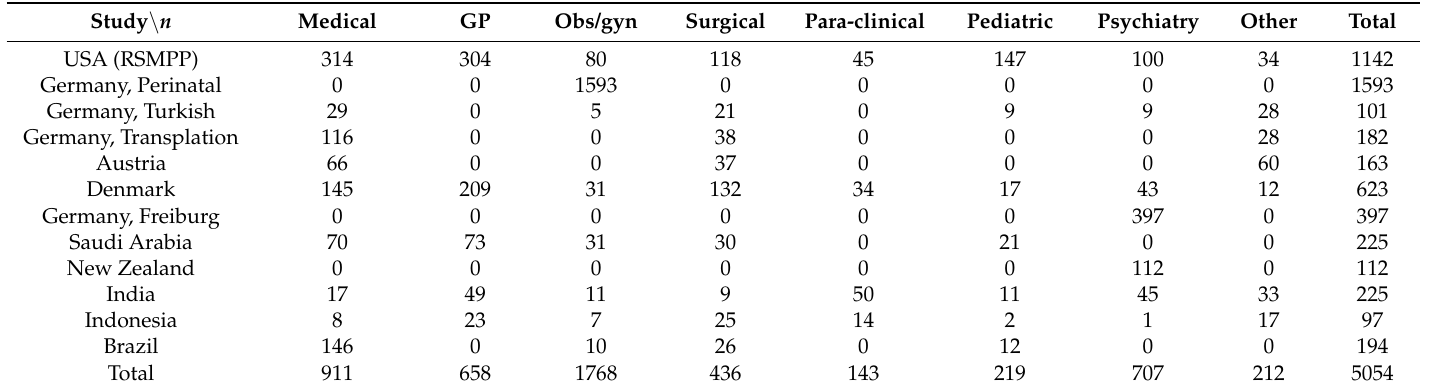
Table 5. Distribution of grouped medical specialties in the studies